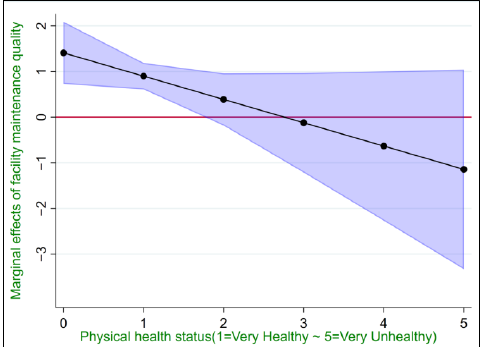
Figure 7. Moderating effect of farmers ’ physical health status on the quality of facility maintenance. Note: The black line in the figure represents the moderating effect of “farmers’ health and physical condition” on the quality of property rights reform affecting facility maintenance. The blue area represents the 95% confidence interval. The red line in the figure represents the significance